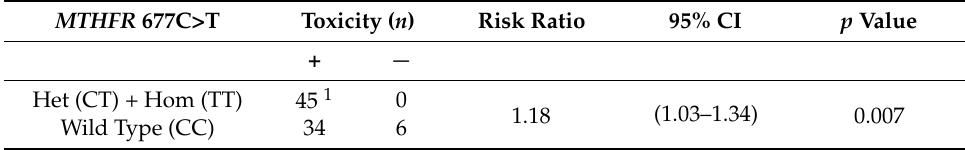
Table 4. Correlation of MTHFR 677C>T polymorphism with the presence of fluoropyrimidine-driven toxicities.